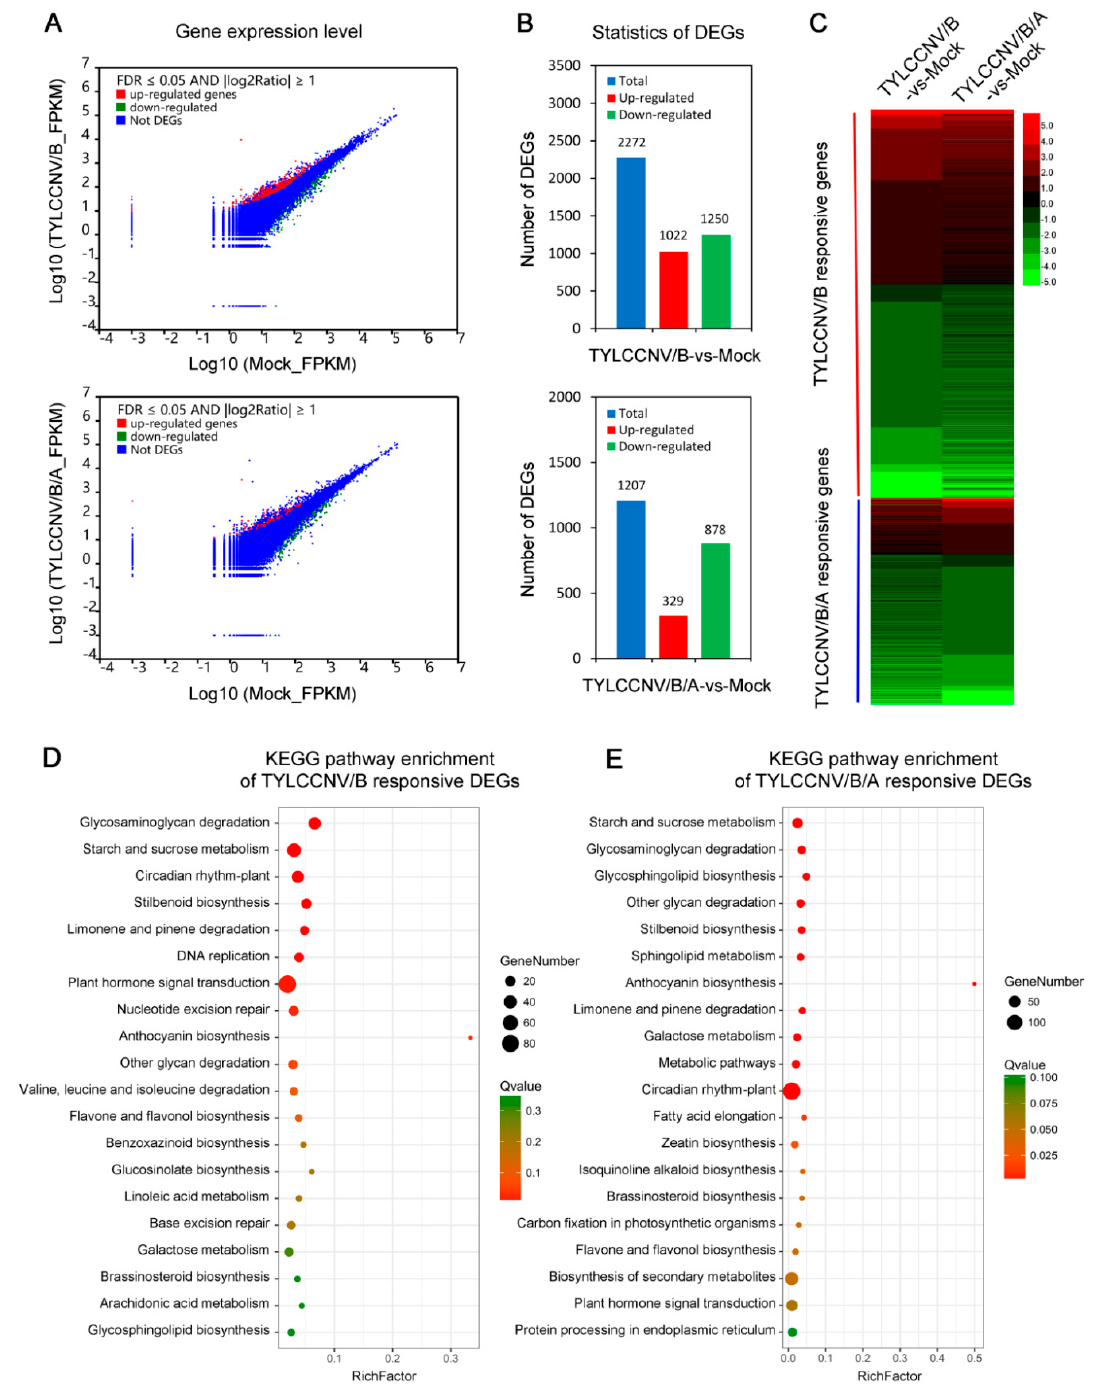
Figure 4. Transcriptional variation of N. benthamiana plants in response to TYLCCNV/TYLCCNB (TYLCCNV/B) and TYLCCNV/TYLCCNB/TYLCCNA (TYLCCNV/B/A) infections. ( A ) Differential expression analysis of all differentially expressed genes (DEGs) in leaves of N. benthamiana seedlings during TYLCCNV/B or TYLCCNV/B/A infections by volcano plots. ( B ) The numbers of total, up-regulated and down-regulated DEGs in leaves of N. benthamiana seedlings during TYLCCNV/B or TYLCCNV/B/A infections. ( C ) Expression profiles of the DEGs between defense responses to TYLCCNV/B and TYLCCNV/B/A infections were shown by a heatmap. The red block indicates the TYLCCNV/B responsive genes and the blue block indicates the TYLCCNV/B/A responsive genes. ( D and E ) KEGG analyses of DEGs in response to TYLCCNV/B ( D ) and TYLCCNV/B/A ( E ). The top 20 enriched KEGG terms are shown.